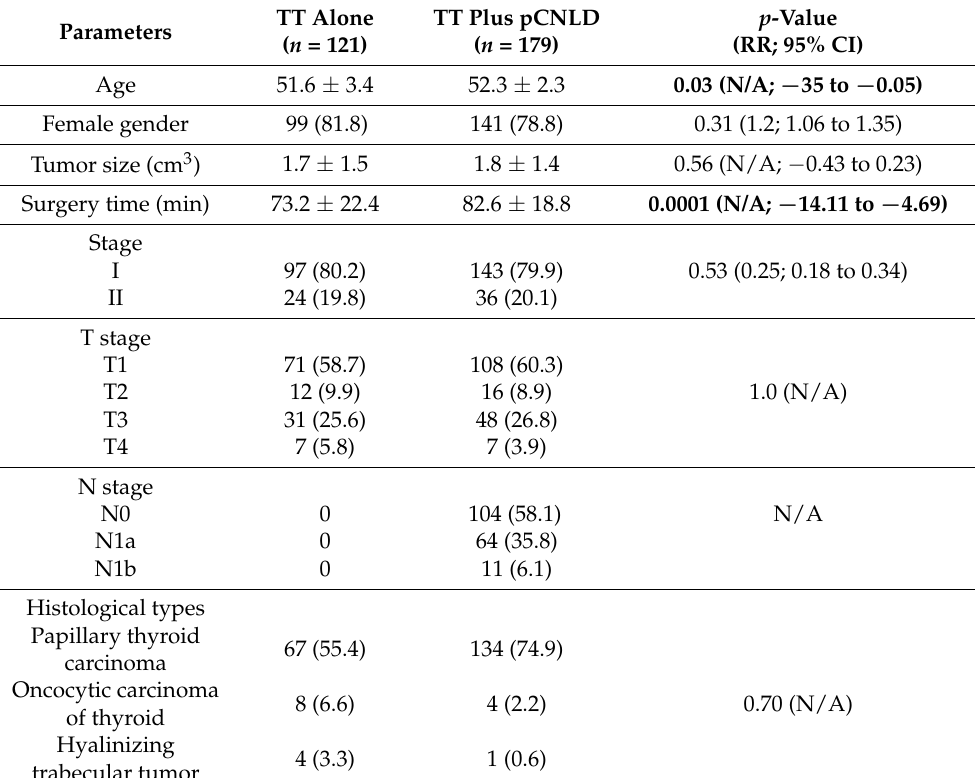
Table 1. Demographic, tumor-related parameters and predictor